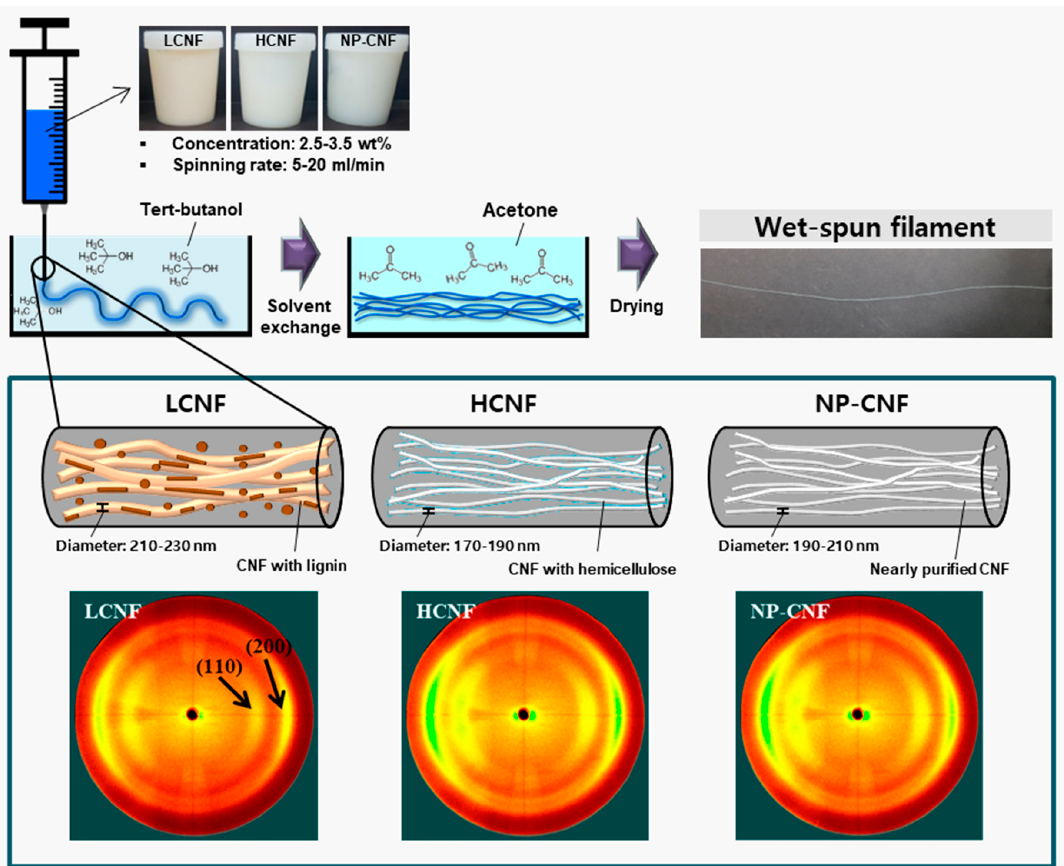
Figure 3. Schematic diagram of wet-spinning and 2D X-ray diffractograms of the wet-spun filaments made from 3.5 wt.% concentration of LCNF, HCNF, and NP-CNF at a spinning rate of 20 mL/min.